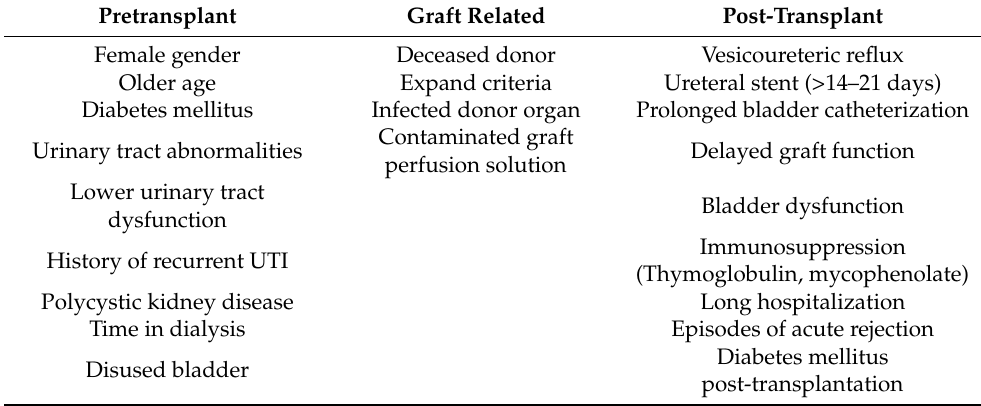
Table 1. Risk factors to urinary tract infection (UTI) in kidney transplant